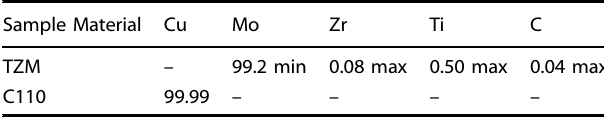
Table 4. Nominal composition of the TZM and copper alloy C110 used to prepare